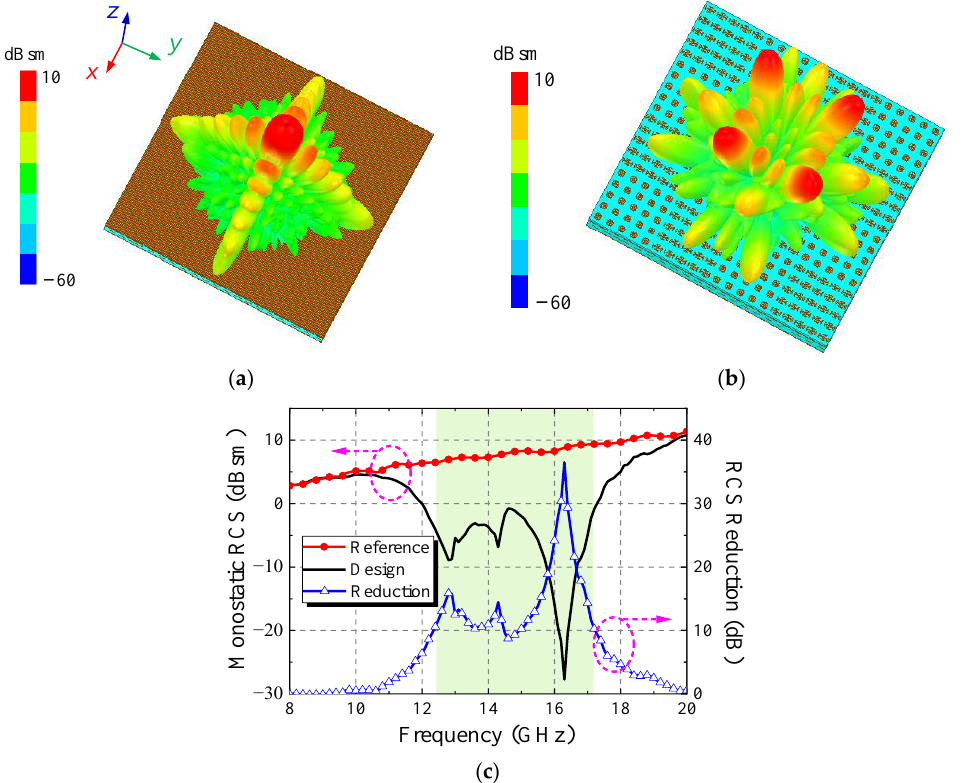
Figure 16. Simulation results of scattering performance on Ku band: ( a ) without cruciform patch; ( b ) checkerboard arrangement with cruciform patch; ( c ) RCS reduction effect in Ku band. The element with h 1 = 3 mm was used for metasurface antenna design, and the